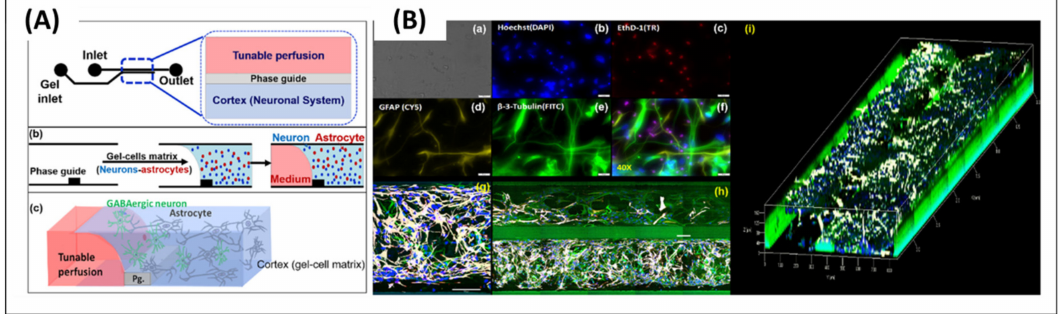
Figure2. ( A )Neurodegenerativediseasemodelingwithvariousneuroncellsources; ( B )Humaninduced pluripotent stem cell (iPSc)-derived neuron based neurodegenerative disease models. Reproduced with permission from Creative Commons Attribution